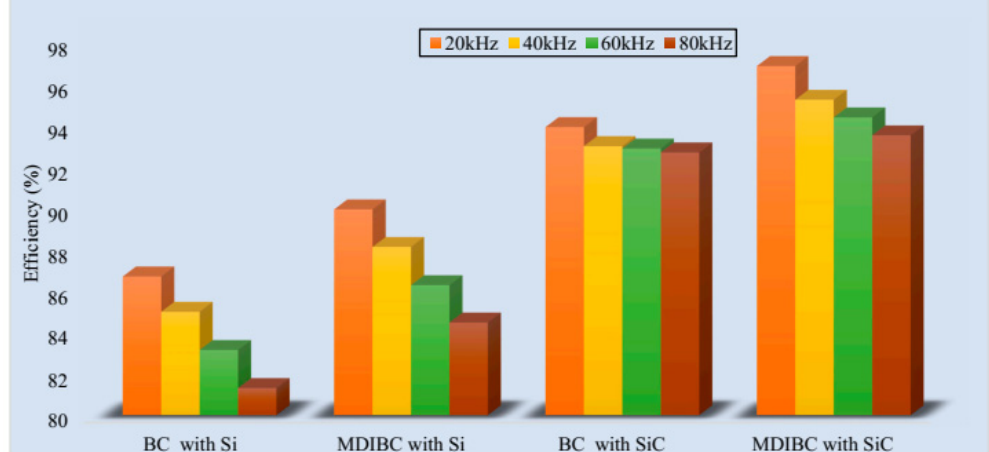
Figure 9. Comparative efficiency measurement of a boost converters and multi-device bidirectional converters using Si versus SiC switches. (Reprinted from Ref. [9].)